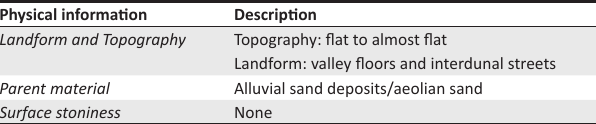
TABLE A1.3a: Differentiating characteristics of the arenic Fluvisols.